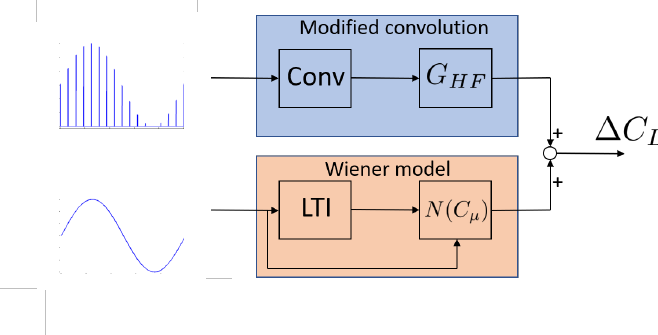
Figure 8. A flowchart of the Wiener-convolution